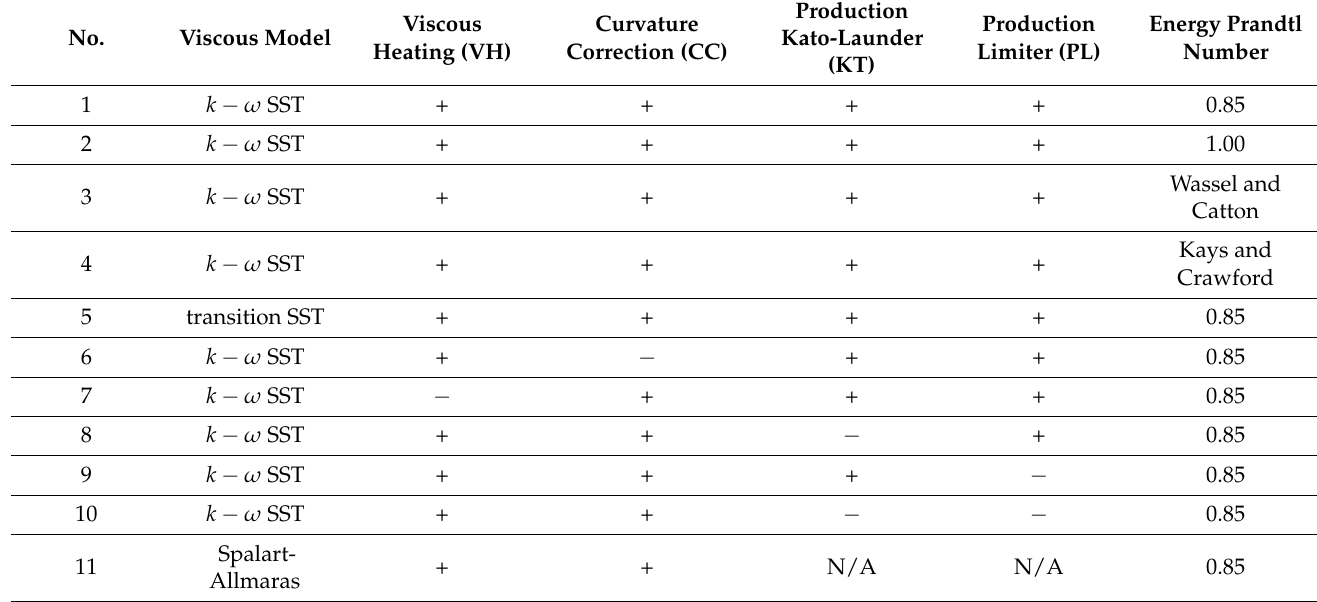
Table 3. Overview of analyzed viscous models (“+” used, “-“ not used, “N/A” not available).